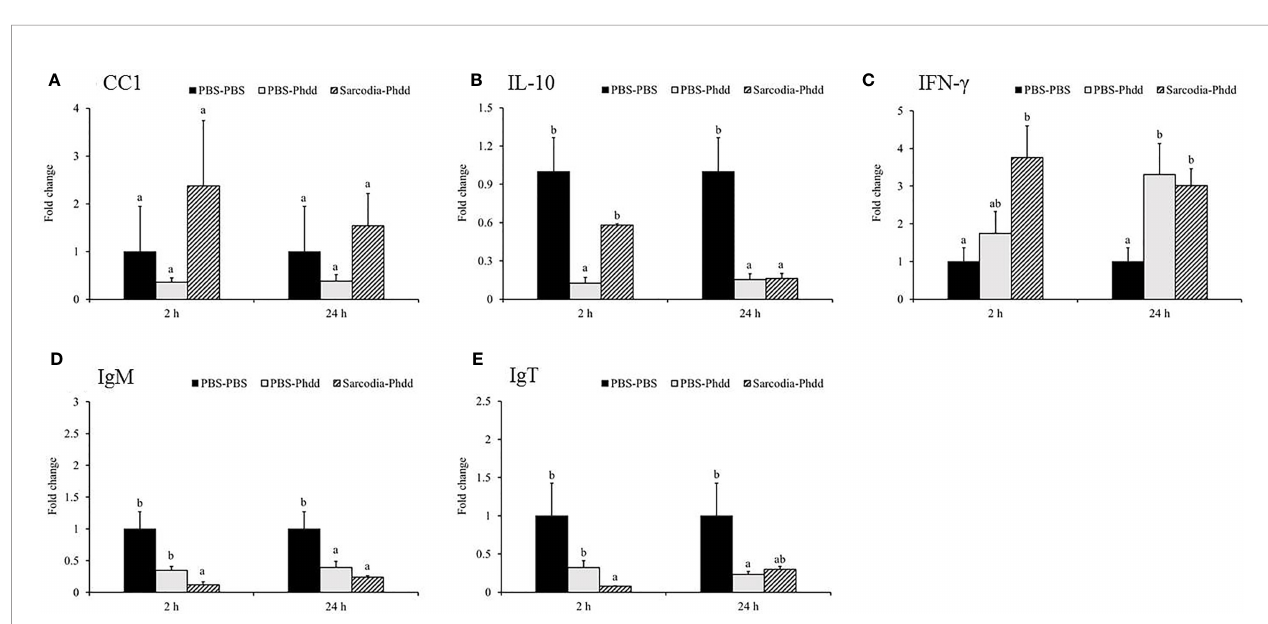
FIGURE 9 | Comparison of transcript level of cytokine genes in the spleen tissue of fi sh intraperitoneal injected with PBS and Sarcodia suiae water extract after challenge with Photobacterium damselae subsp. damselae ( Phdd ). The relative expression pro fi le of (A) IL-6 , (B) IL-8 , (C) TNF a , and (D) IL-12 in the spleen samples was analyzed. The values are shown as mean + SEM (N = 3). Signi fi cant differences ( p < 0.05 ) are indicated by different letters.